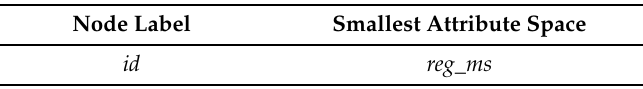
Table 3. The format of bcut _